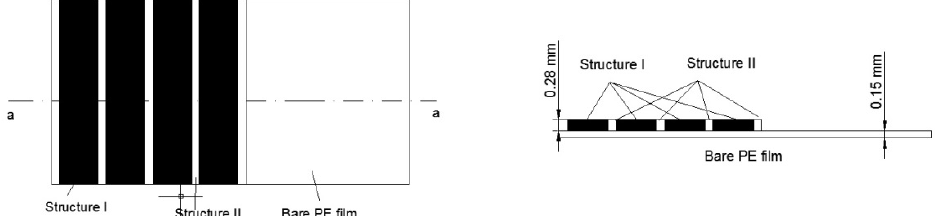
Figure 2. Transparent organic photovoltaic (OPV) / greenhouse cover combinations.